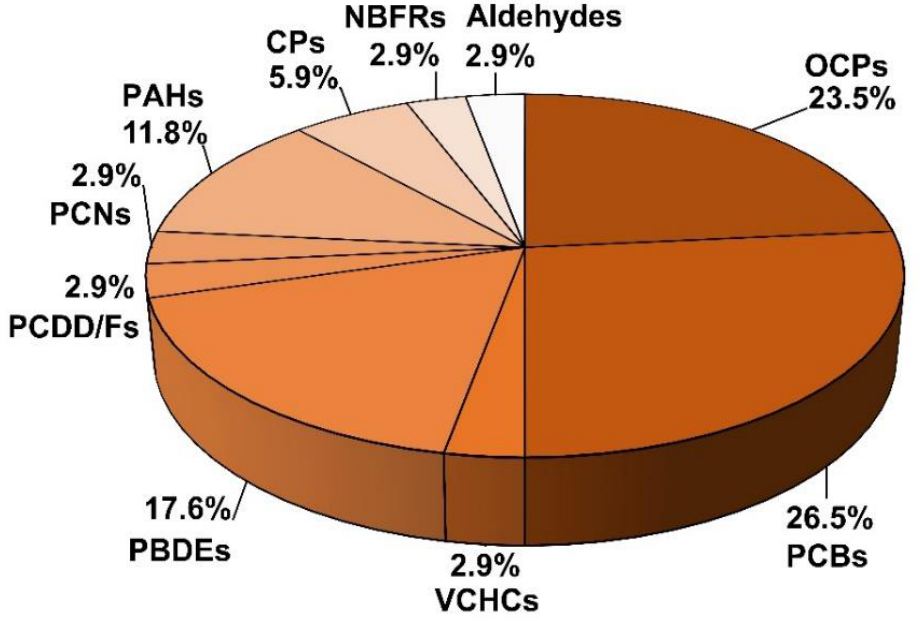
Figure 1. Relative abundance of each organic pollutant reported in Antarctic region from 2000 to 2021.